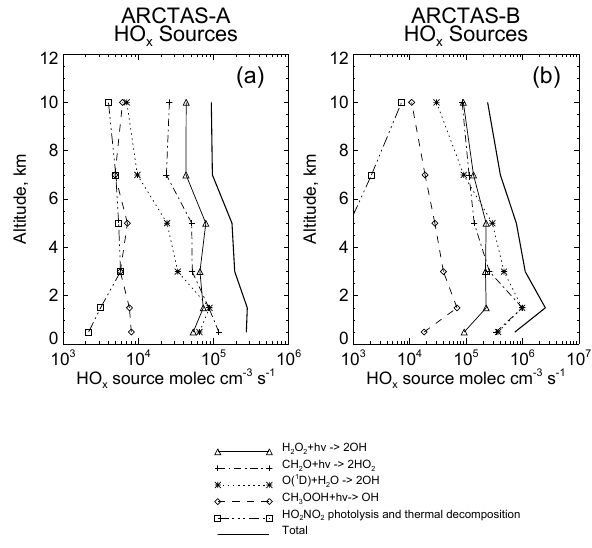
Fig. 7. Gross HO x production during (a) ARCTAS-A and (b)